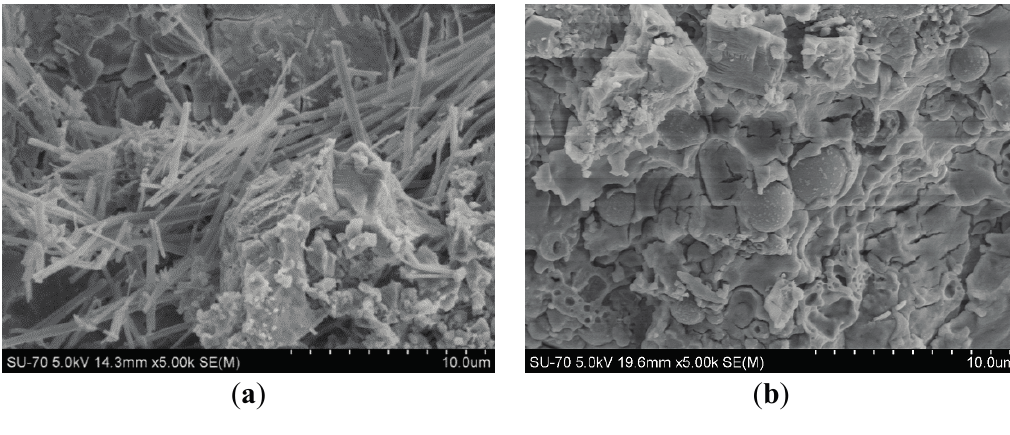
Figure 12. SEM of MPC paste matrix. ( a ) Acicular hydrate products in paste; ( b ) Fly ash particle in the paste.